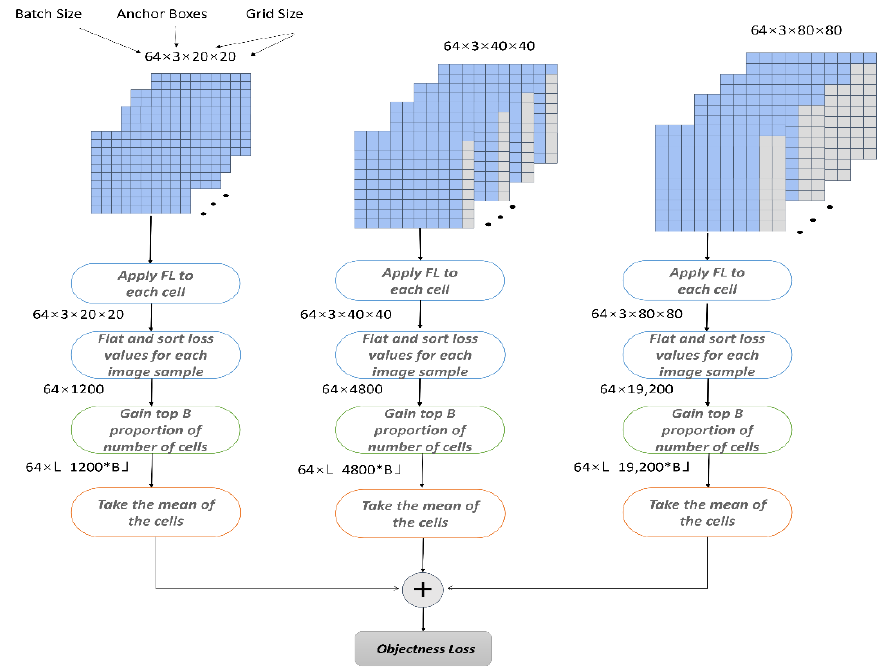
Figure 7. Comprehensive loss function calculation diagram.